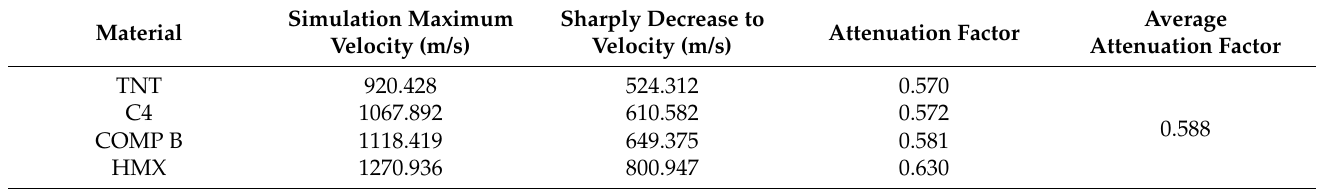
Table 8. Velocity attenuation in the second stage.